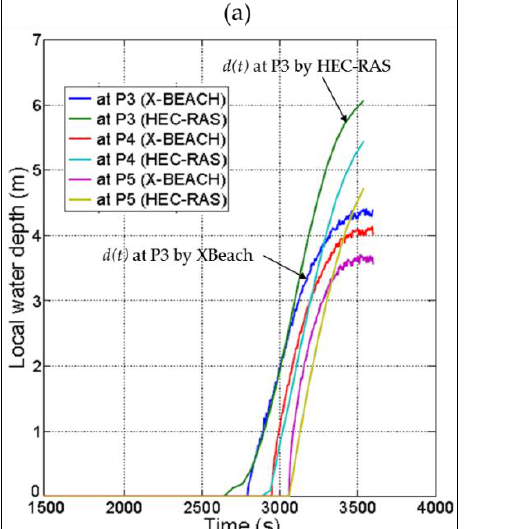
Figure 10 . Comparison of local water depths ( a ) and local depth-averaged velocities ( b ), calculated by both HEC-RAS and XBeach (1D) at the measuring point P3, P4 and P5 under the rectangular load (LC1).